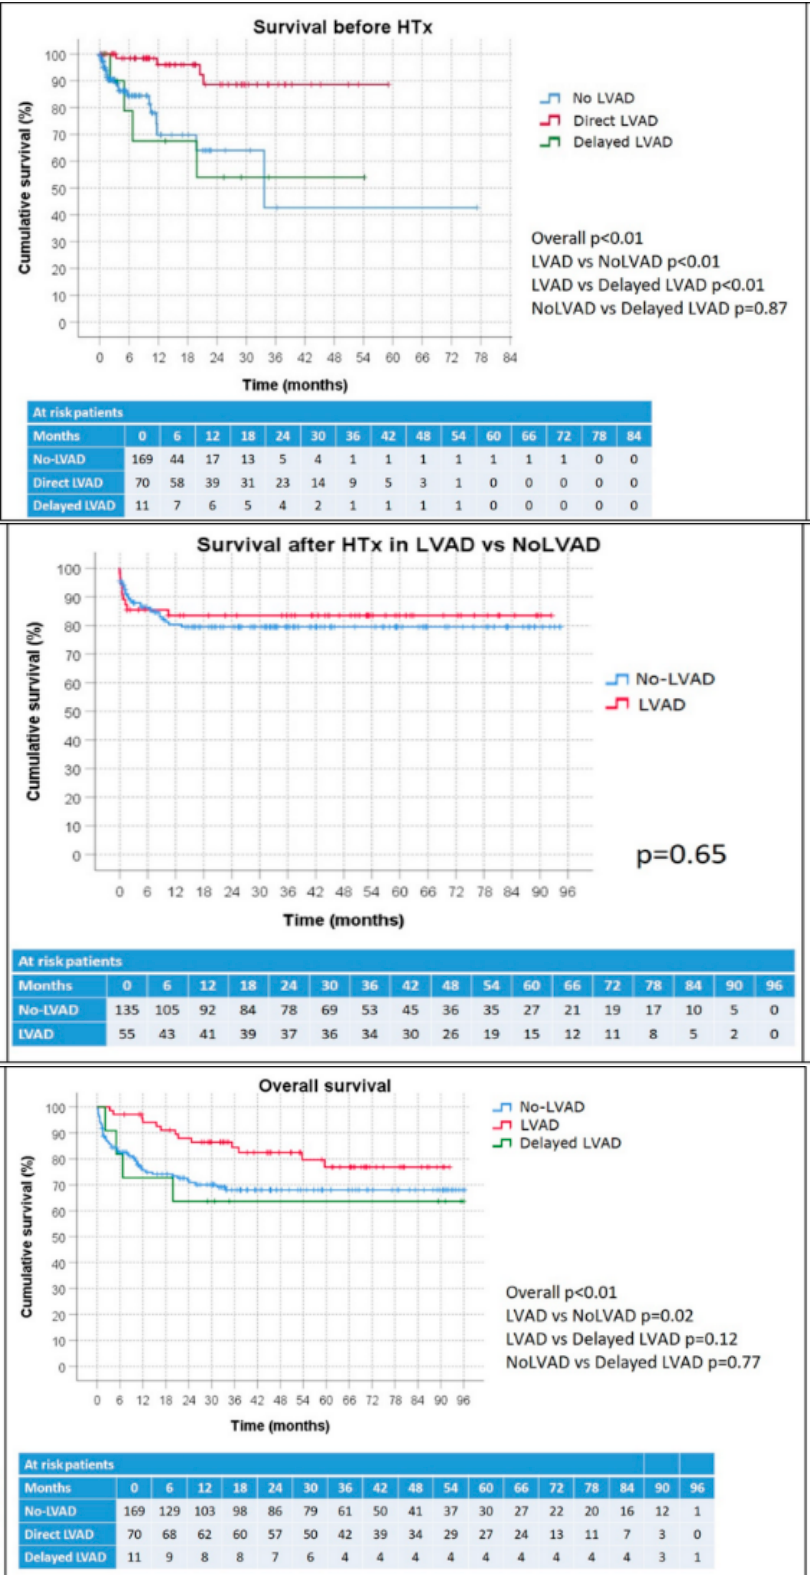
Figure 1. Kaplan–Meier plots of survival before HTx stratified according to LVAD use, survival after HTx in LVAD vs. no-LVAD patients, and overall survival according to LVAD use.